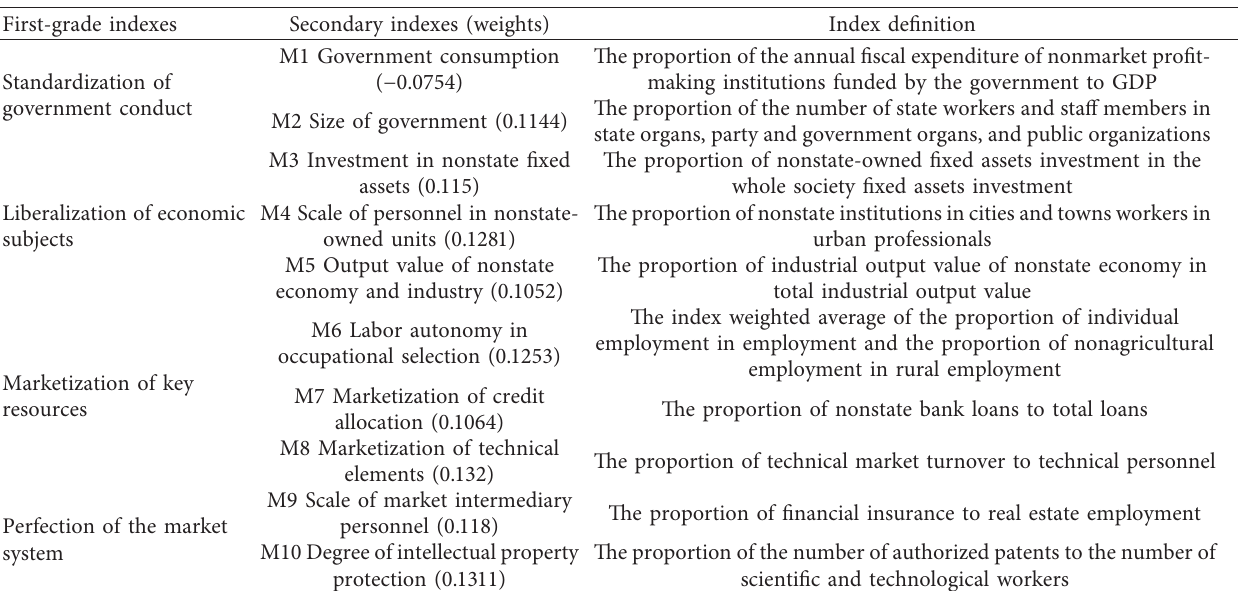
Figure 3: Static coupling degree, dynamic coupling degree, and the coupling coordination degree between SE and EE in each province, 1990–2019. Table 2: Index system of